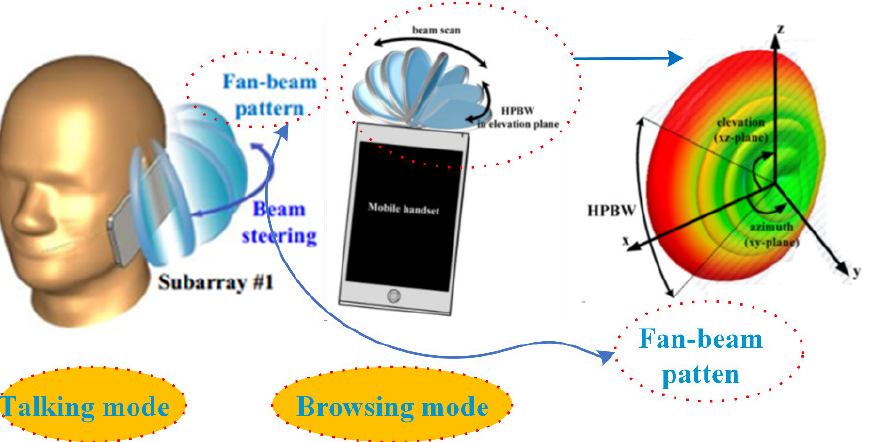
Figure 5. Beam steering idea for talking and browsing modes; the idea behind the figure has been brought from [7].